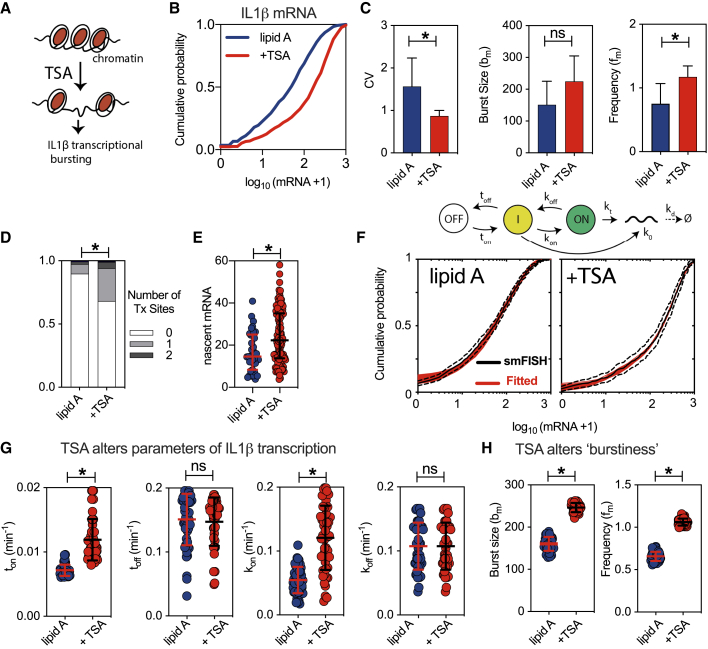
Modulation of Transcriptional Bursting via Chromatin State(A) Schematic representation of the treatment protocol: cells exposed to 10 μM TSA for 1 h before 500 ng/mL lipid A treatment.(B) TSA alters IL-1β mRNA distribution. Cumulative probability distribution of smFISH mRNA counts in BMDMs pre-treated with TSA prior to lipid A stimulation (+TSA; as in A), or control cells stimulated with lipid A. Shown is the IL-1β levels expressed as log10(mRNA+1) pooled across at least three replicates, from 732 (lipid A) and 305 (lipid A +TSA) cells, respectively.(C) Characteristics of single-cell mRNA expression. Shown is the CV, bm, and fm calculated based on moments of the mRNA count data from (A) (expressed as mean ± SD from experimental replicates). “∗” denotes a result of a two-sample Mann-Whitney U test between groups (p < 0.05; ns, not significant).(D) Distribution of Tx in data from (B). Shown is the fraction of cells with 0–2 Tx. “∗” denotes a result of the Fisher exact test (p < 0.05) for the difference in the Tx site distribution.(E) Nascent IL-1β mRNA counts (with means and SDs) from 35 (lipid A) and 114 (lipid A +TSA) Tx from (D), respectively. “∗” denotes a result of two-sample Mann-Whitney U test between groups (p < 0.05).(F) Comparison between the measured and fitted IL-1β mRNA counts across conditions from (B). In black: Kaplan-Meier estimator of the measured CDF (with 95% confidence intervals); and in red: a family of models (50) fitted to the data. (Top) schematics of the fitted transcriptional model.(G) TSA modulates kinetic parameter rates in the fitted IL-1β models. Shown are selected parameter values (with mean and SD) for families of fitted models from (F). “∗” denotes a result of a two-sample Mann-Whitney U test between groups (p < 0.0001, ns).(H) TSA alters bursting characteristics of IL-1β expression. Shown are the moment estimates (mean and SD) of the burst size and frequency for fitted mRNA distributions from F. “∗” denotes a result of a two-sample Mann-Whitney U test between groups (p < 0.0001).